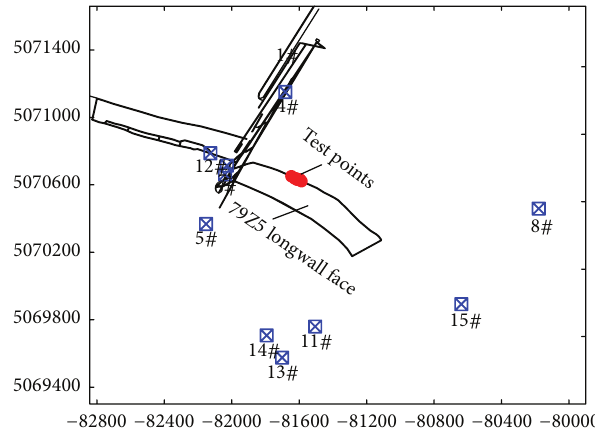
Figure 3: Plan of sensors layout.